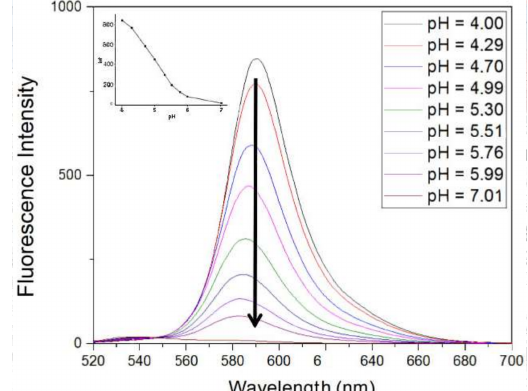
Figure 1. pH response of RhB-EDA in different pH from pH 4 to pH 7 ( λ ex / λ em = 500 nm/590